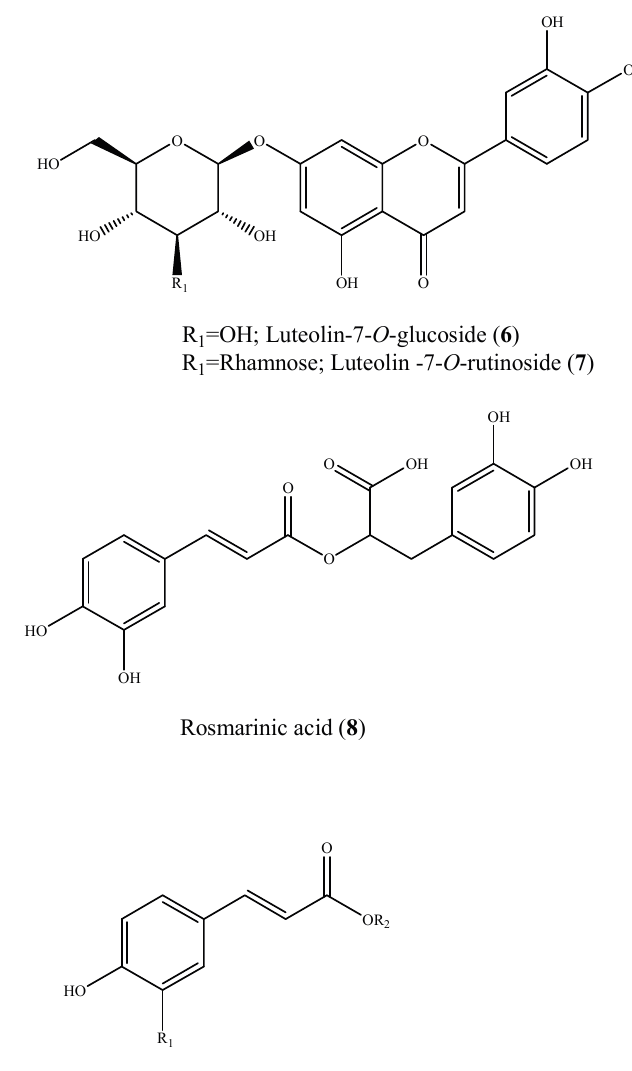
Figure 1. Structures of the constituents isolated from Colocasia esculenta (L.) Schott.